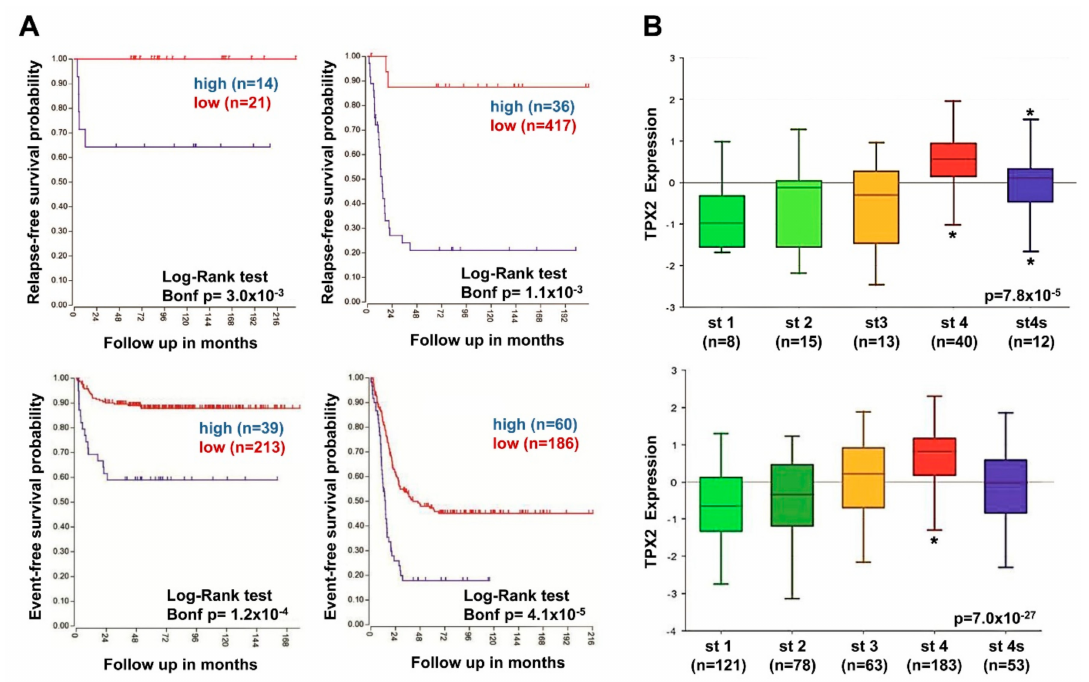
Figure 7. Neuroblastoma patient outcomes based on TPX2 expression and disease stage. ( A ) Using the neuroblastoma Versteeg (top) and SEQC (bottom) patient datasets, survival curves were generated for patients with stage 1, 2, and 4S tumors (left) and with stage 3 and 4 tumors (right). Relapse-free survival (top) and event-free survival (bottom) curves are shown, with patient numbers in parentheses. ( B ) Relative TPX2 expression levels from the Versteeg (top) and SEQC (bottom) patient data sets were plotted in patients with disease stage (st) 1, 2, 3, 4, and 4S, respectively, with patient numbers shown in parentheses (* p <